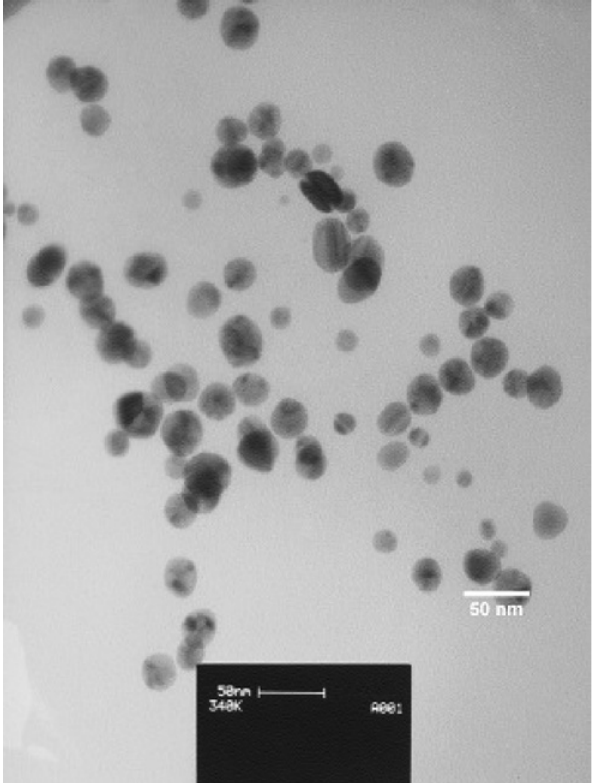
Figure 9: TEM image of the synthesized AuNPs using mushroom